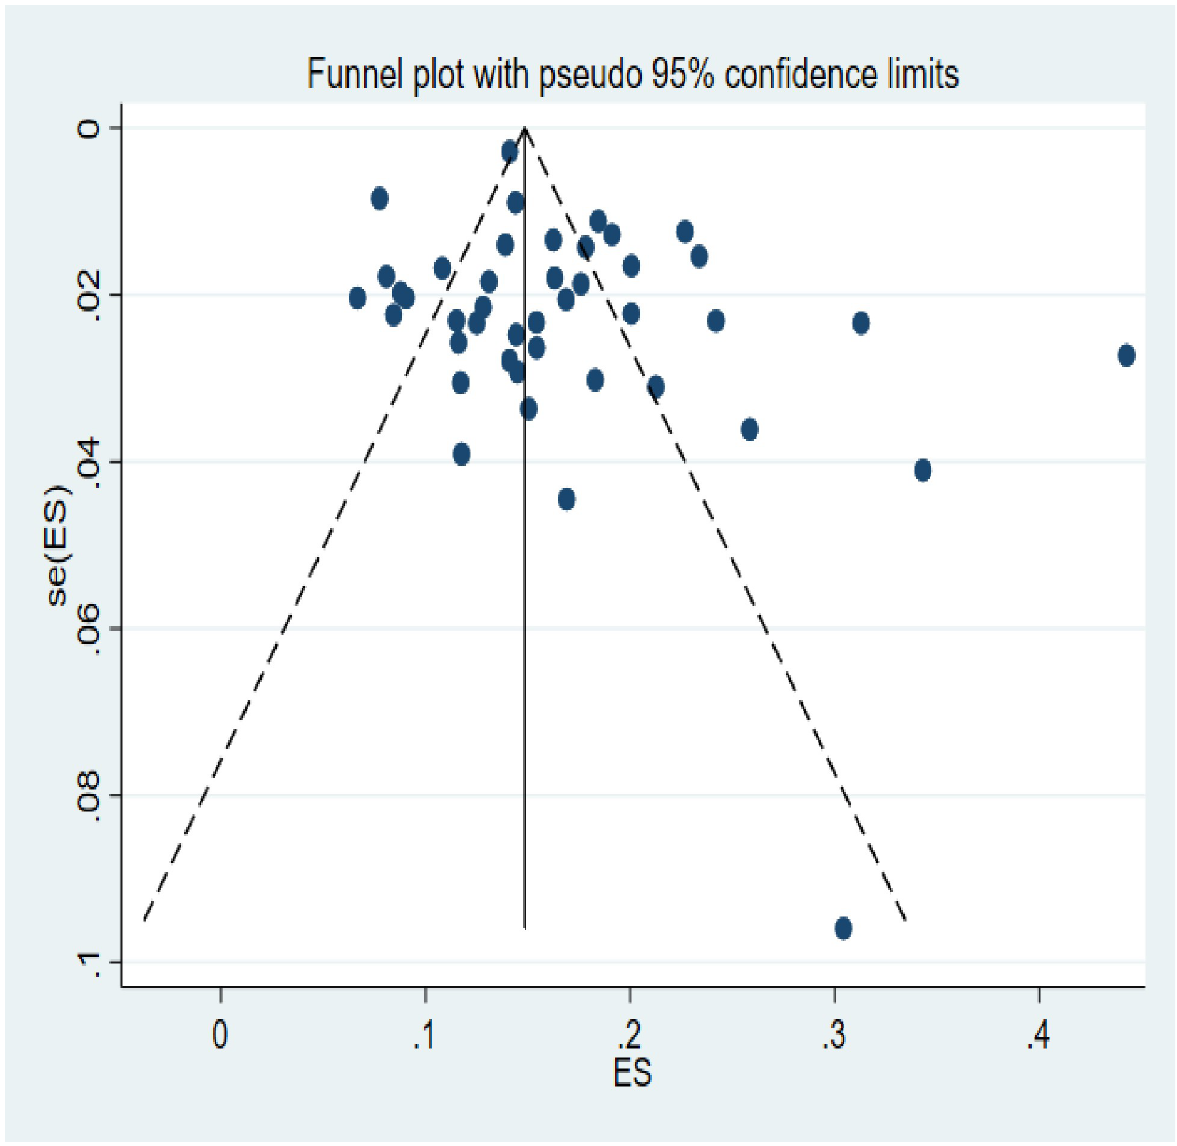
Fig 5. Funnel plot of standard error by effect size for publication